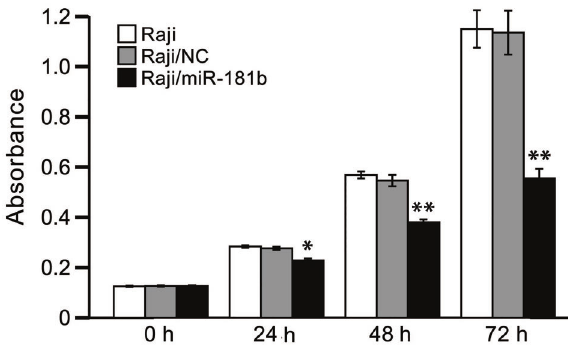
Figure 6. Effect of miR-181b on Raji cell viability. After transfection for 24, 48, and 72 h, cell viability was signi fi cantly decreased in the Raji/miR-181b group compared with the Raji and Raji/normalized control (NC) groups, *P o 0.05, **P o 0.01 (ANOVA). Data are reported as means ± SD (n=6).